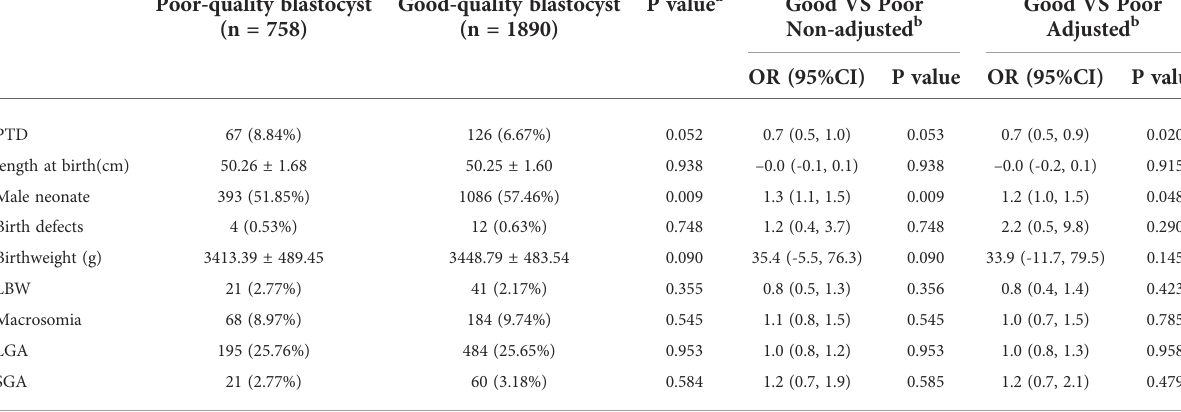
TABLE 2 Perinatal outcomes of live-born singletons according to quality of blastocyst transferred.